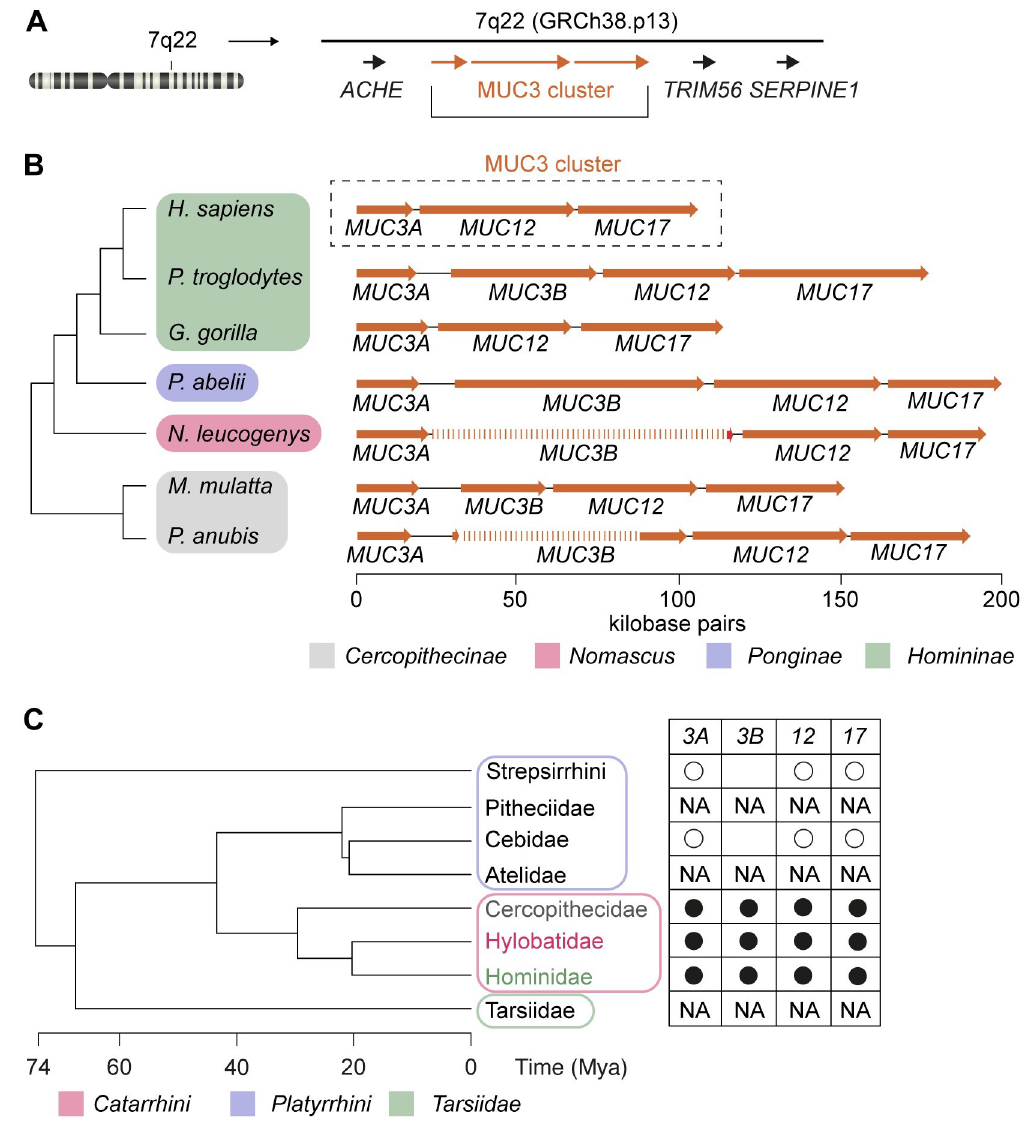
Fig 1. Conservation of MUC3 cluster in Cercopithecoid and Hominoid superfamilies. (A) The MUC3 cluster at locus q22 in human chromosome 7 in the GRCh38.p13 assembly is flanked by genes ACHE , TRIM56 , and SERPINE1 . (B) Members of the Cercopithecoid and Hominoid superfamilies, except for H . sapiens and G . gorilla , carry a MUC3 cluster consisting of MUC3A , MUC3B , MUC12 , and MUC17 genes. (C) Presence of the MUC3B gene in MUC3 cluster in Catarrhini parvorder (filled black circles). Open circles indicated the presence of MUC3 , MUC12 , and MUC17 genes in the Platyrrhini parvorder. NA indicates a lack of sufficient sequence information for the detection of MUC3 cluster